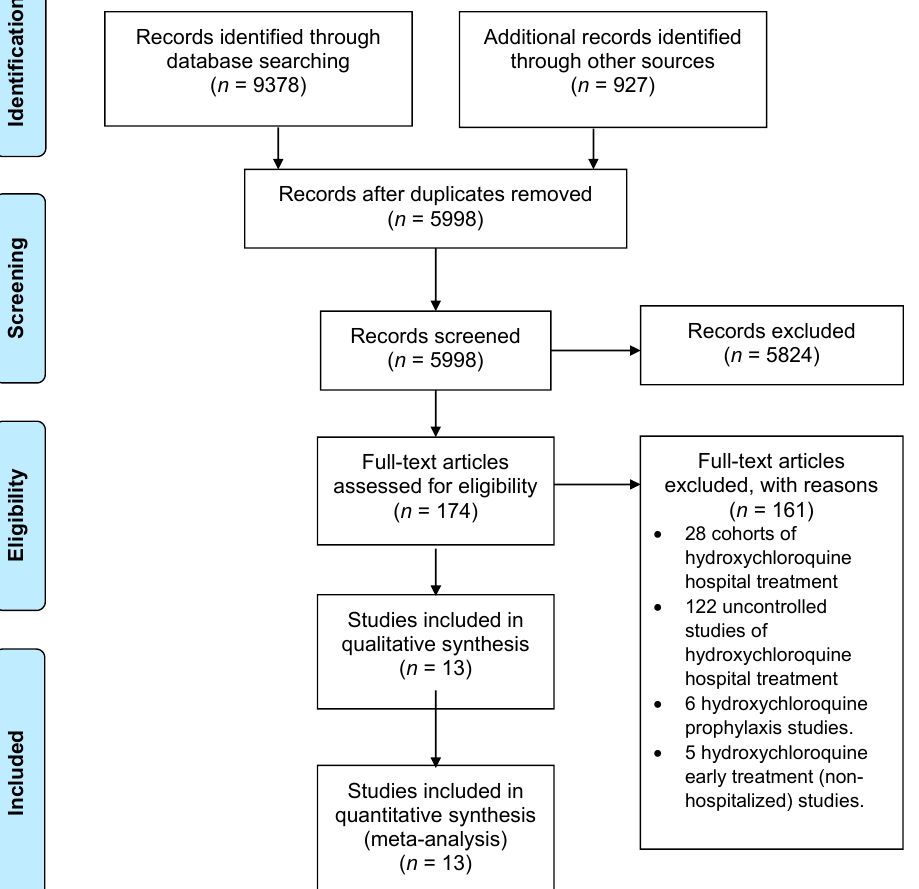
Figure 1. Flow chart of study